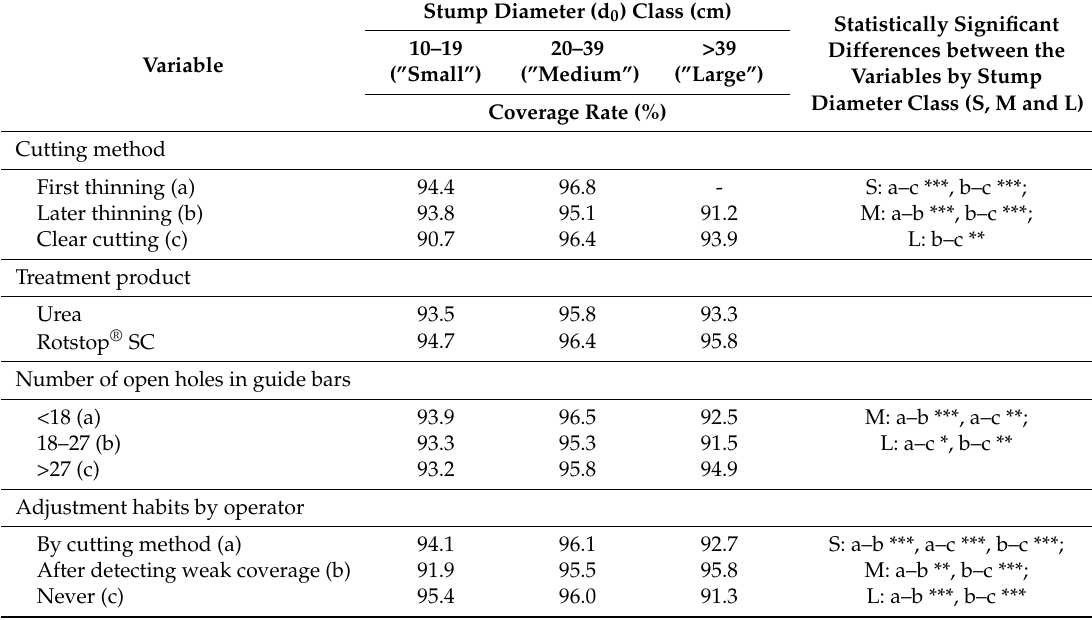
Table 5. The average coverage rates by stump diameter class in the